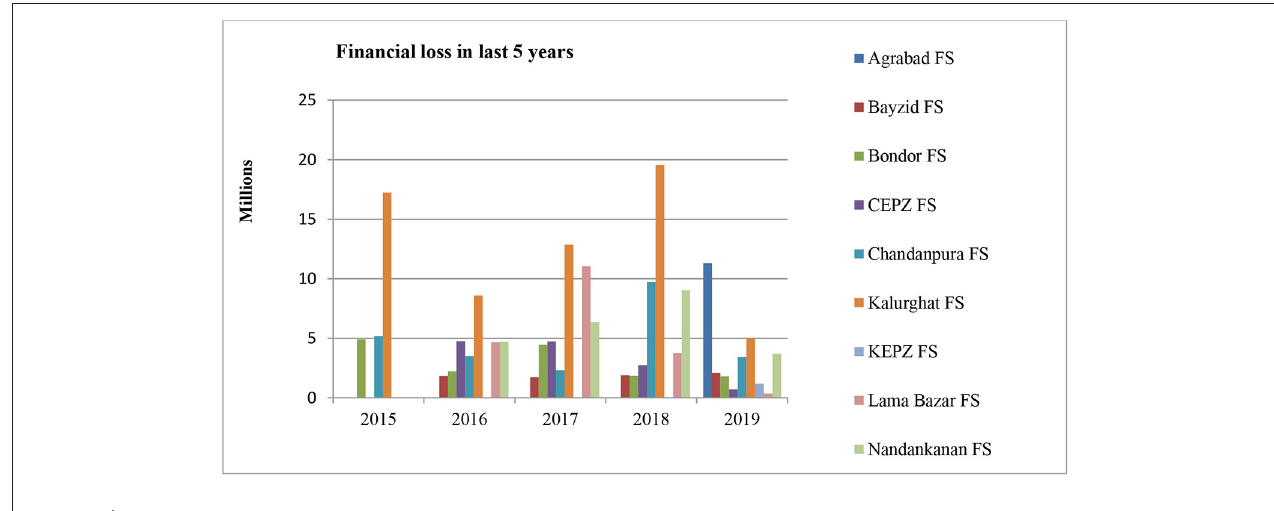
FIGURE 7 | Financial loss within the last 5 years in the CCC area.